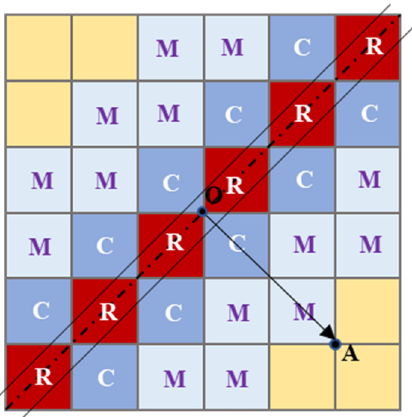
Figure A1. Schematic diagram of buffer settings on both sides of a closed road.